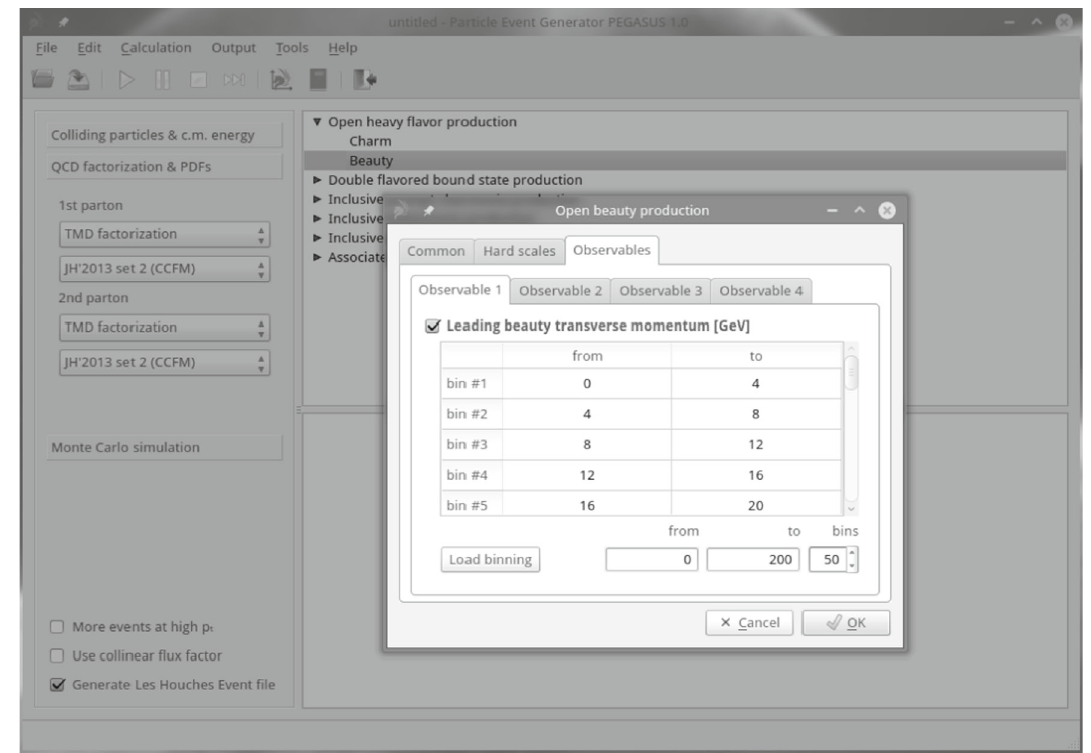
Fig. 4 One can optionally correct the default kinematical restrictions, list of requested observables and corresponding binnings for any processes (part 3)